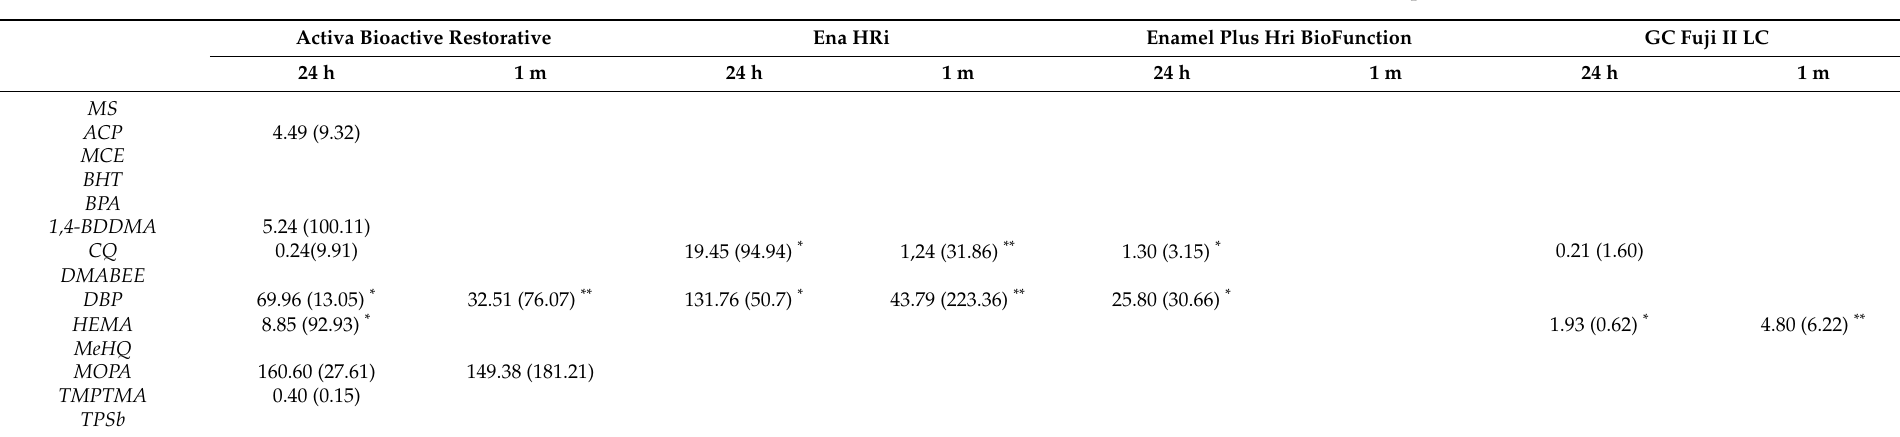
* Indicates significant difference among the materials, ** indicates significant difference according to observation periods. Table 5. Median values of relative amounts (%CF) for eluates measured in methanol extracts for both observation periods (24 h and 1 month). Activa Bioactive Restorative